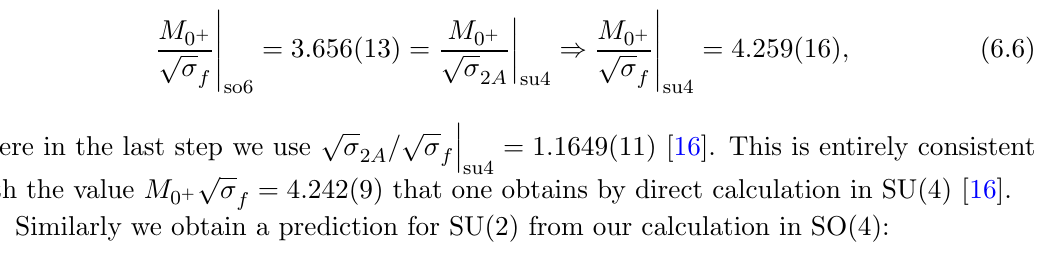
( (cid:15) ), (cid:22) = g 2 N ( (cid:14) ) and (cid:22) = 10 0 +